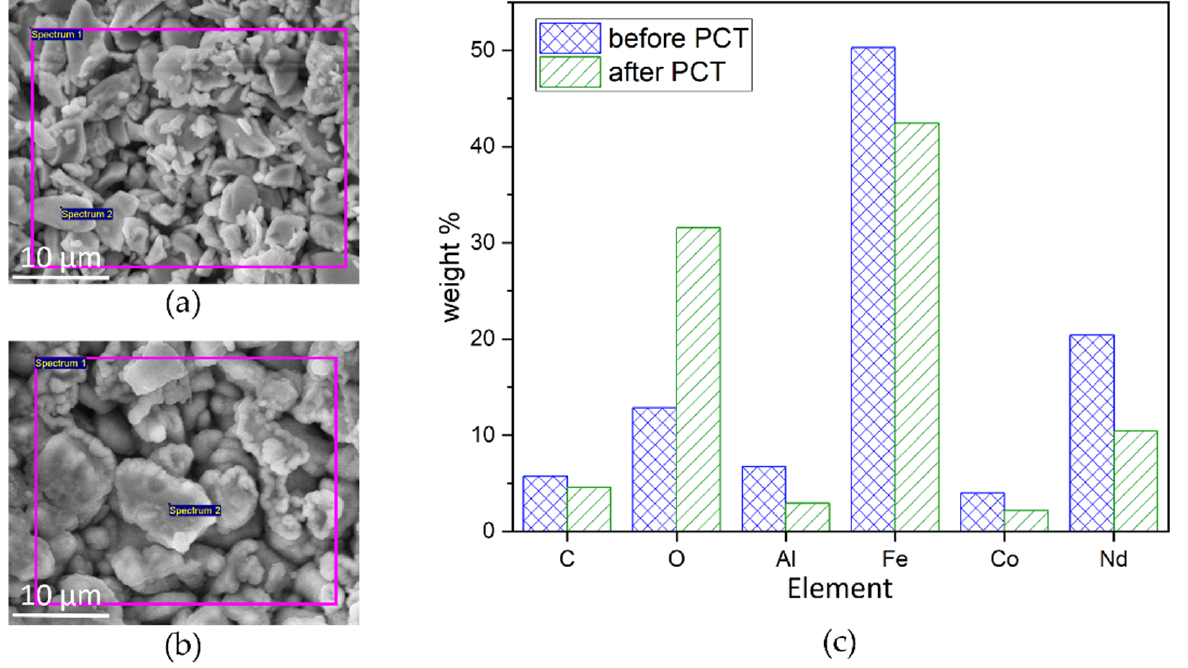
Figure 13. SEM micrographs of NdFeB particles solidified by Al 2 O 3 ( a ) before PCT and ( b ) after PCT. The violet frames indicate the area of elemental analysis by EDX. ( c ) Results of elemental analysis before and after PCT. A significant increase in O 2 indicates corrosion of the NdFeB.